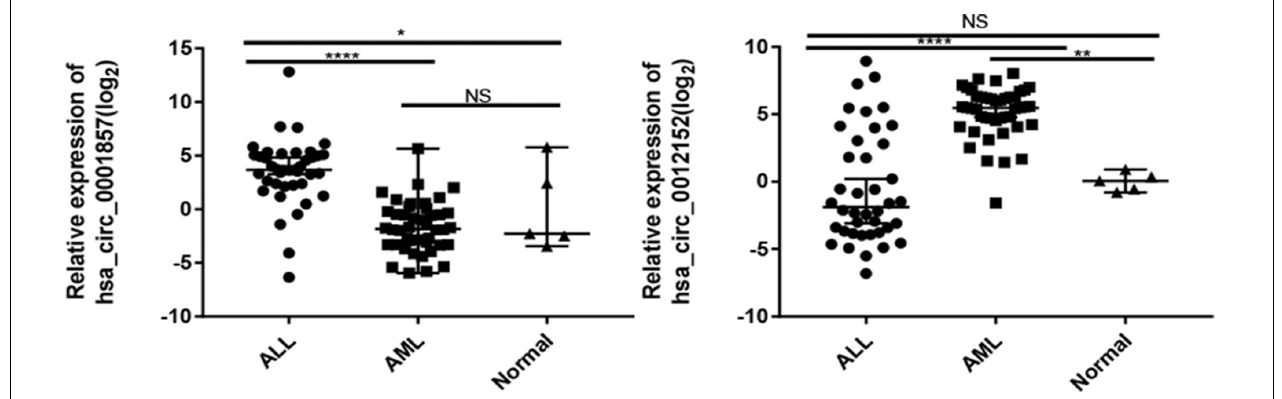
FIGURE 3 | Expression of hsa_circ_0001857 and hsa_circ_001252 in a cohort of patients with acute leukemia. * P < 0.05, ** P < 0.01, **** P < 0.0001; NS, no significance.